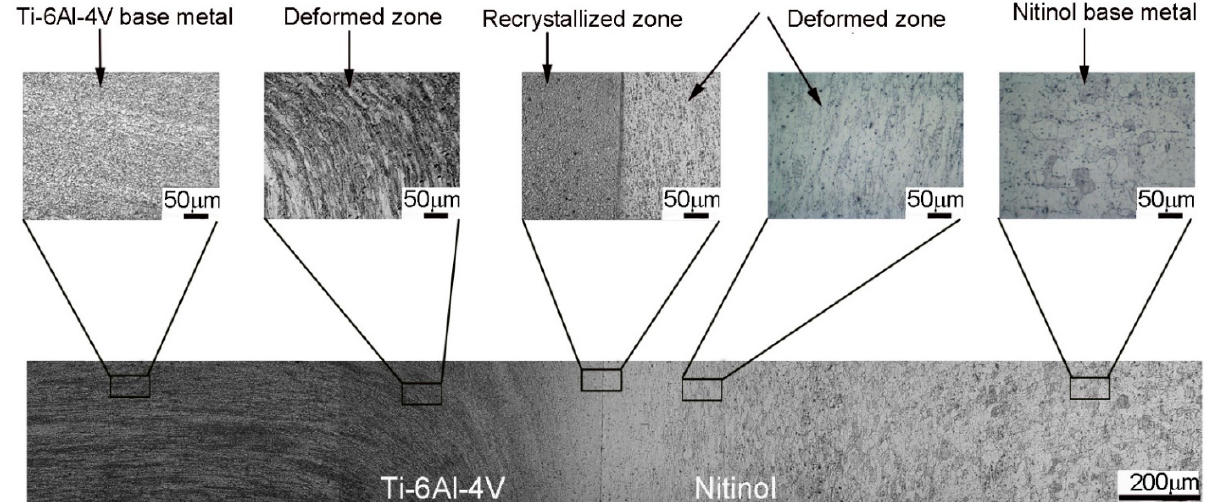
Figure 6. The optical microstructure of the Ti-6Al-4V/Nitinol linear friction welds in the as-welded condition.